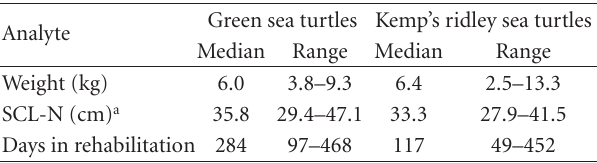
Table 1: Size data and time in rehabilitation for green ( n = 10) and Kemp’s ridley ( n = 10) sea turtles investigated for the e ff ects of feeding on hematology and plasma biochemistry